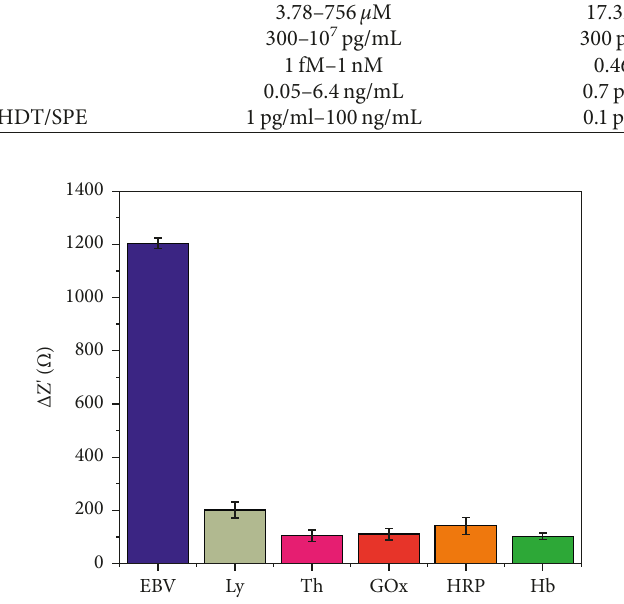
Figure 7: Antiinterference performance of the proposed electrochemical sensor.